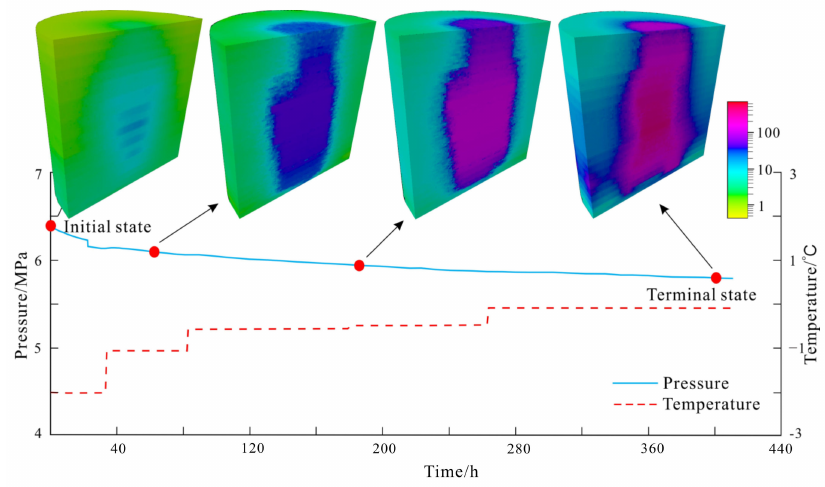
Figure 4. Three-dimensional resistivity image of the massive hydrate during the formation of hydrate. The top and bottom bound of images are the top and bottom boundary of the cylindrical array.